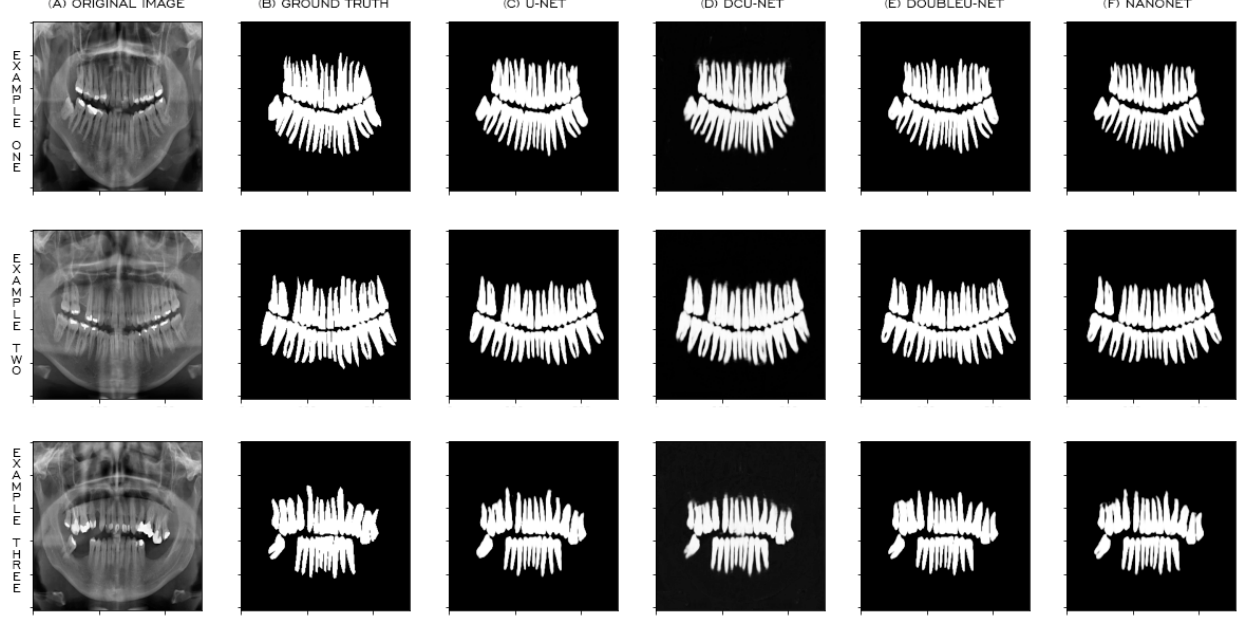
Figure 5. Example of three panoramic radiograph images tested by segmentation models with data